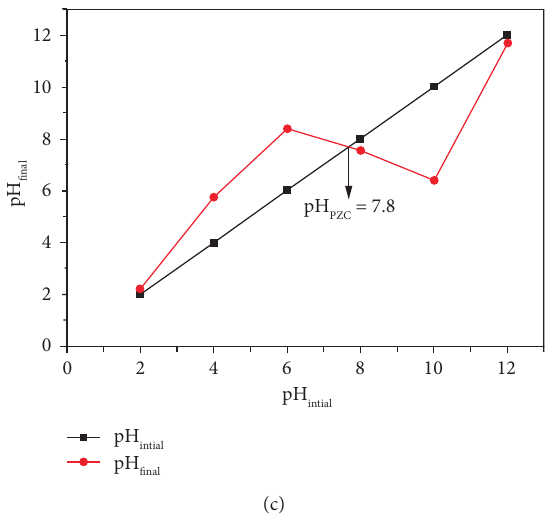
Figure 6: Photodegradation of TA in as-prepared samples, (b) the kinetic curves, and (c) the pH conditions: dosage catalyst 0.5g/L, tartrazine concentration of 20mg/L, and pH �